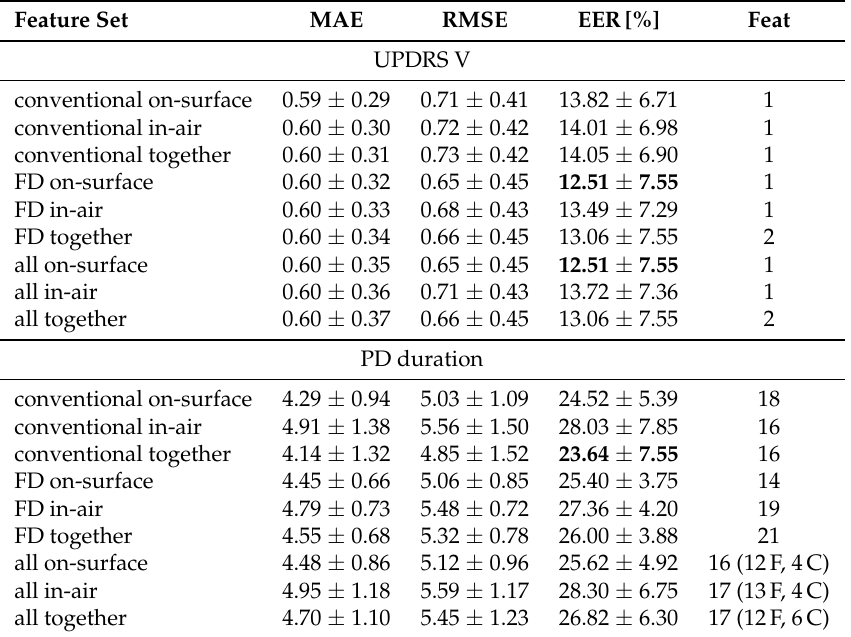
Table 7. Results of regression analysis for clinical